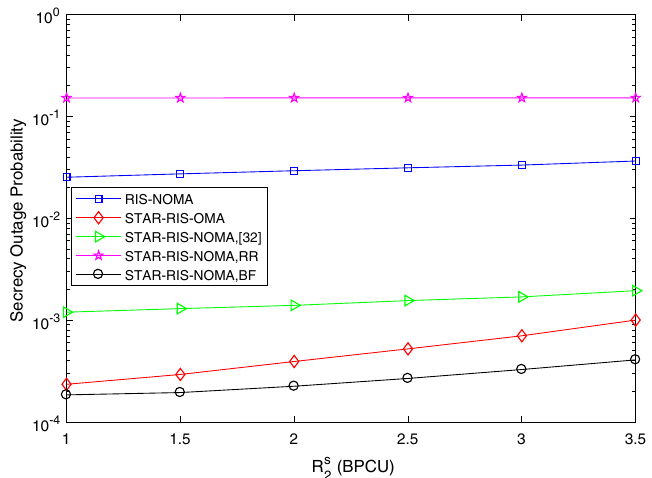
Fig. 8 The SOP versus the secrecy rate requirement of the cell-center user. When the transmission power is constant, the influence of different secrecy rate requirement of user U 2 on the